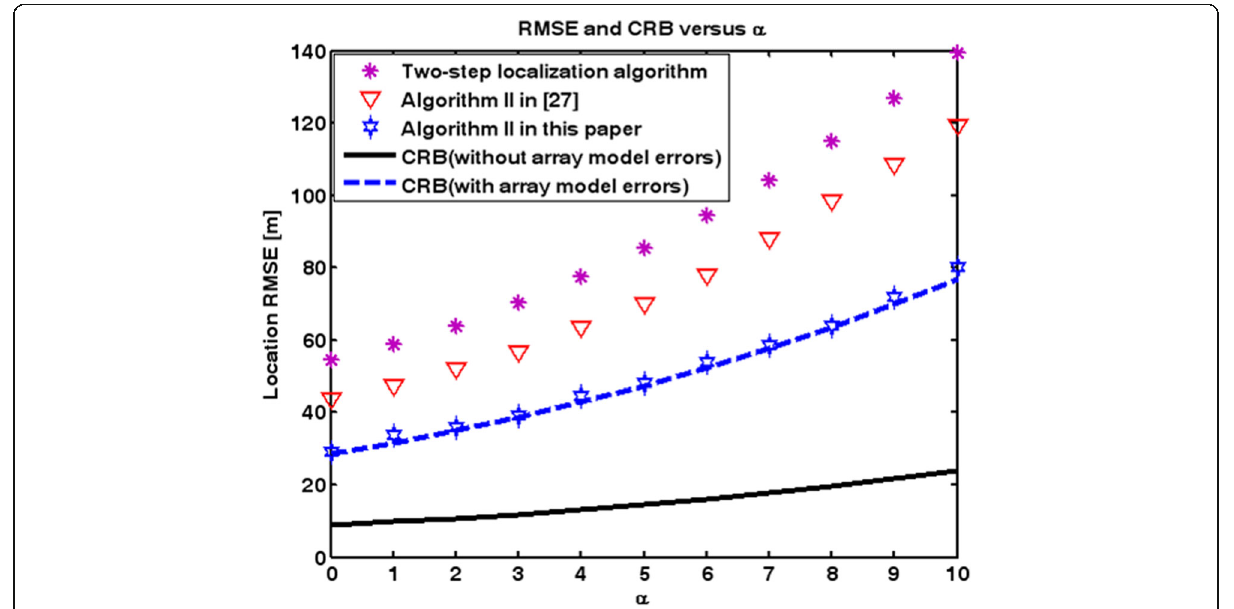
Fig. 12 RMSEs of localization methods and the corresponding CRBs as a function of α for case of known signal waveform